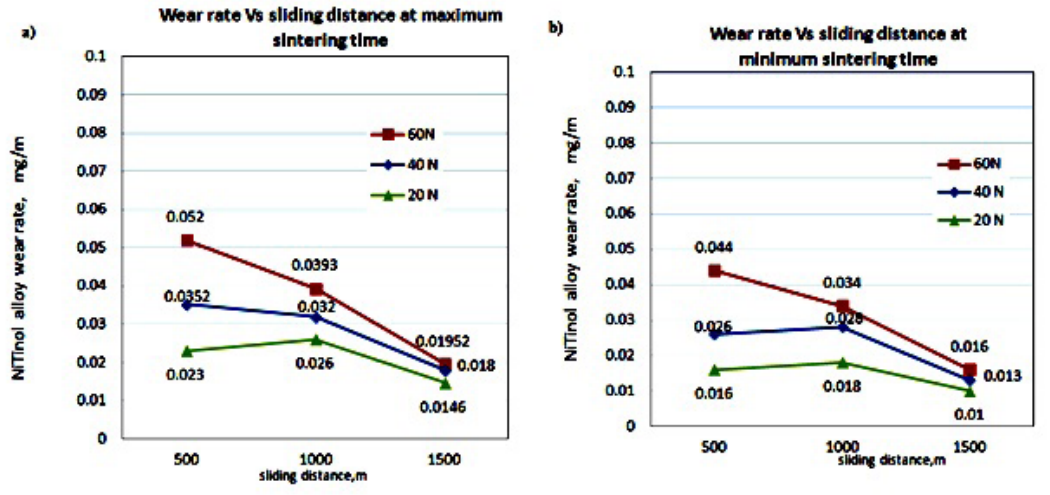
Figure 12. Wear rate of Nitinol composite with varying sliding distance a) at maximum sintering time b) at minimum sintering